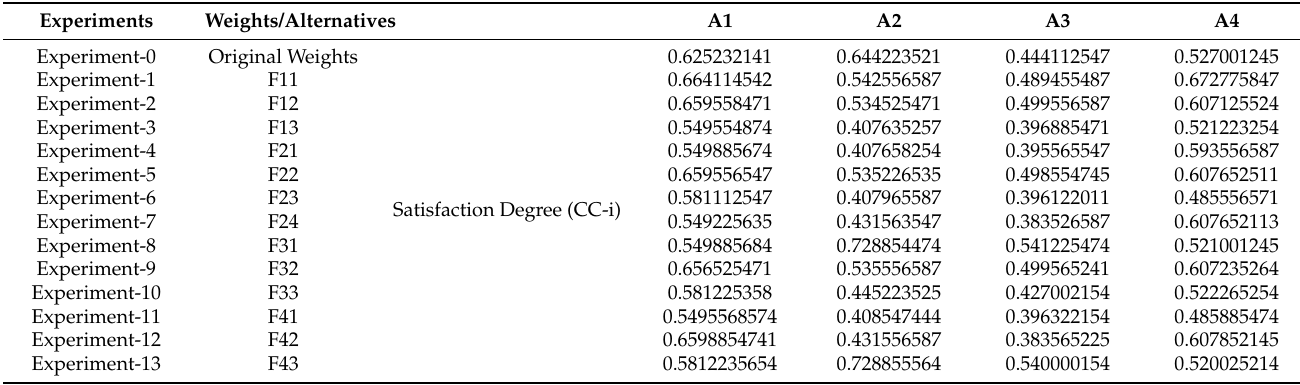
Table 7. Sensitivity analysis.